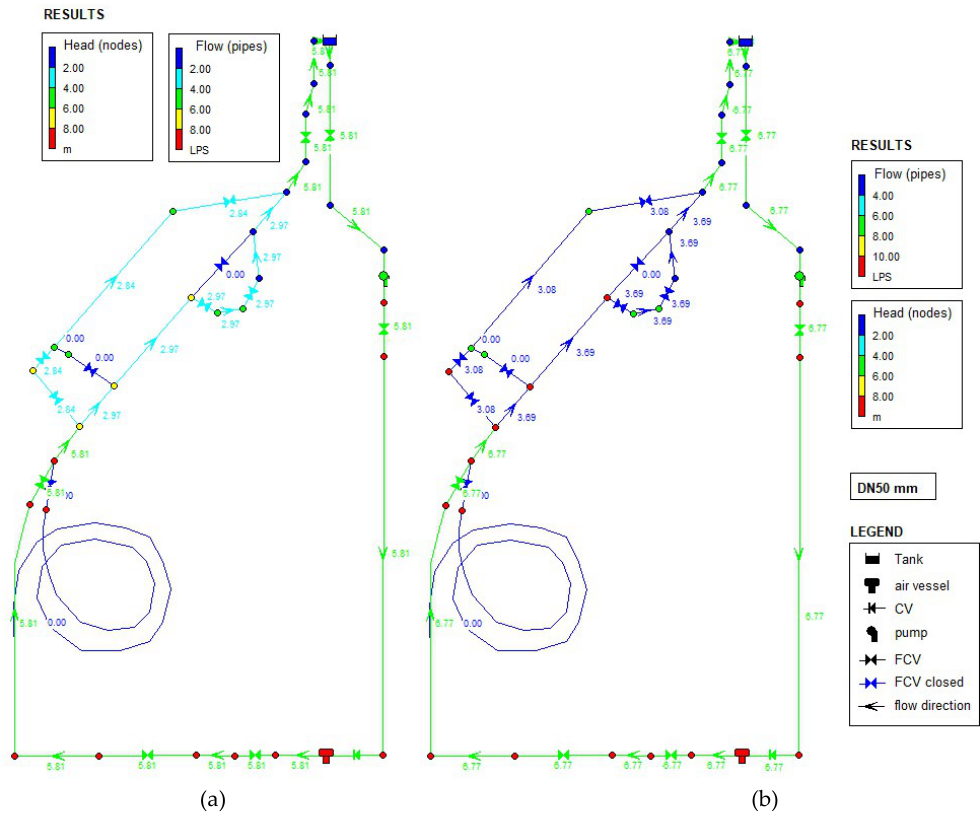
Figure 8. Calibration of the network: ( a ) scenario 1—Q = 5.81 L/s; ( b ) scenario 2—Q = 6.77 L/s.